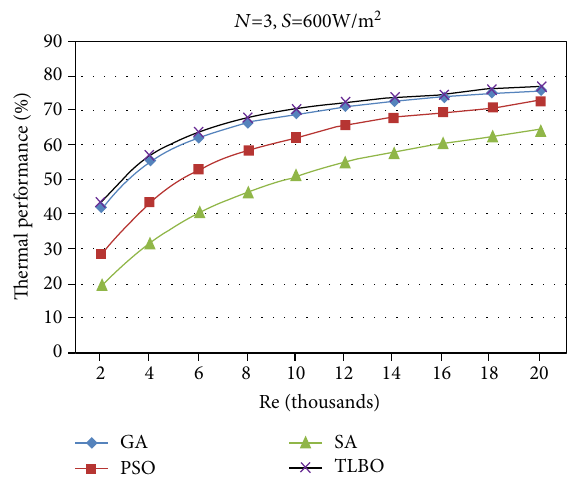
Figure 11: Thermal e ffi ciency of metaheuristic algorithms against Reynolds number [24].